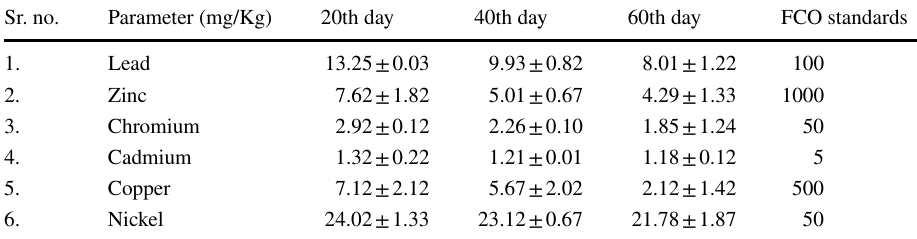
Table 5 Heavy metal analysis of compost in Solan (H.P)